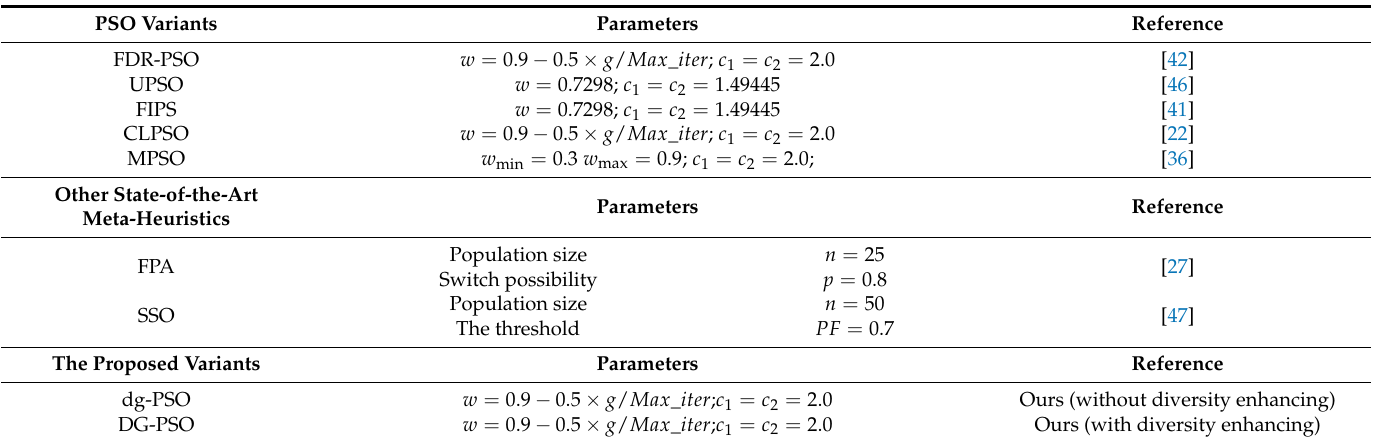
Table 2. Parameters and references of the involved